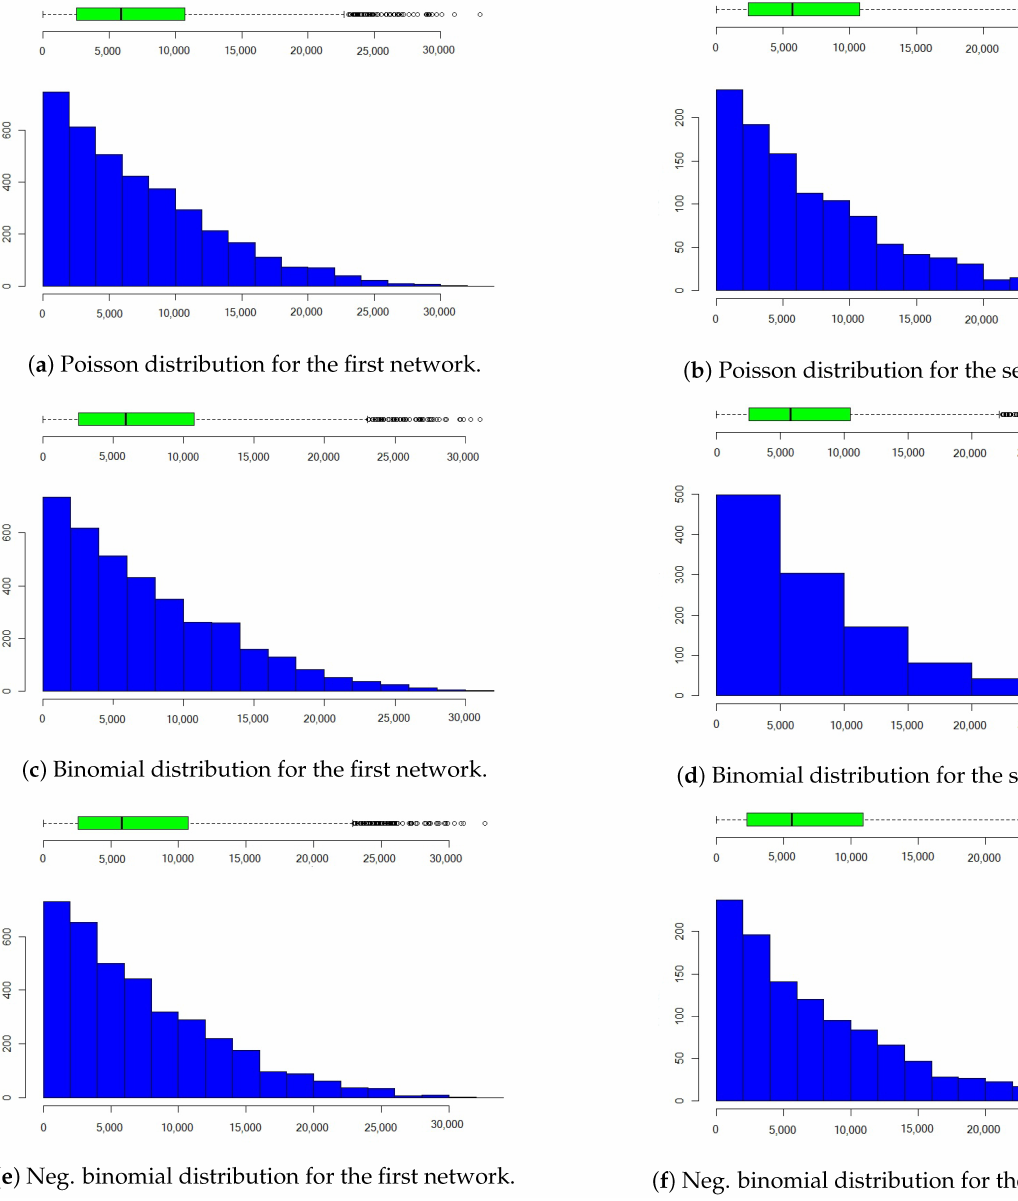
Figure 9. Distributions of the number of communication for one year contract usiang a link-based model. Table 5. Descriptive statistics for the weight of both networks created using a link-based model. Desc.